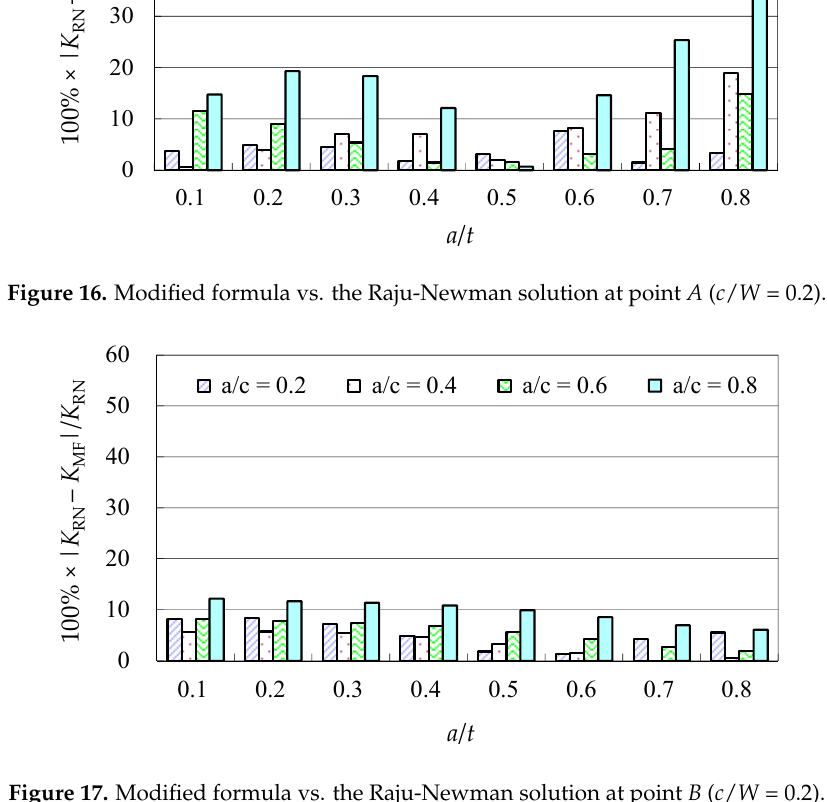
Figure 17. Modified formula vs. the Raju-Newman solution at point B ( c / W = 0.2).